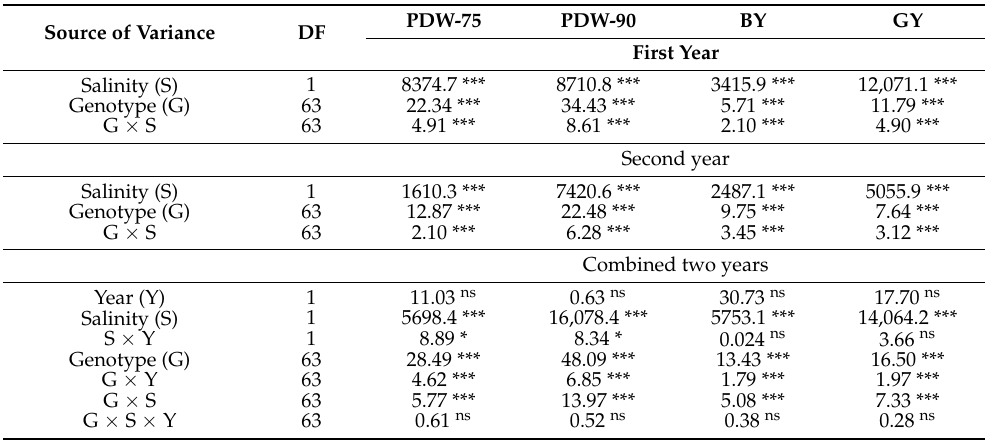
Table 2. Analysis of variance (F-values) for plant dry weight measured at 75 (PDW-75) and 90 (PDW-90) days after sowing, biological yield (BY), and grain yield (GY) of 64 wheat genotypes for each year and the combined analysis of two years.